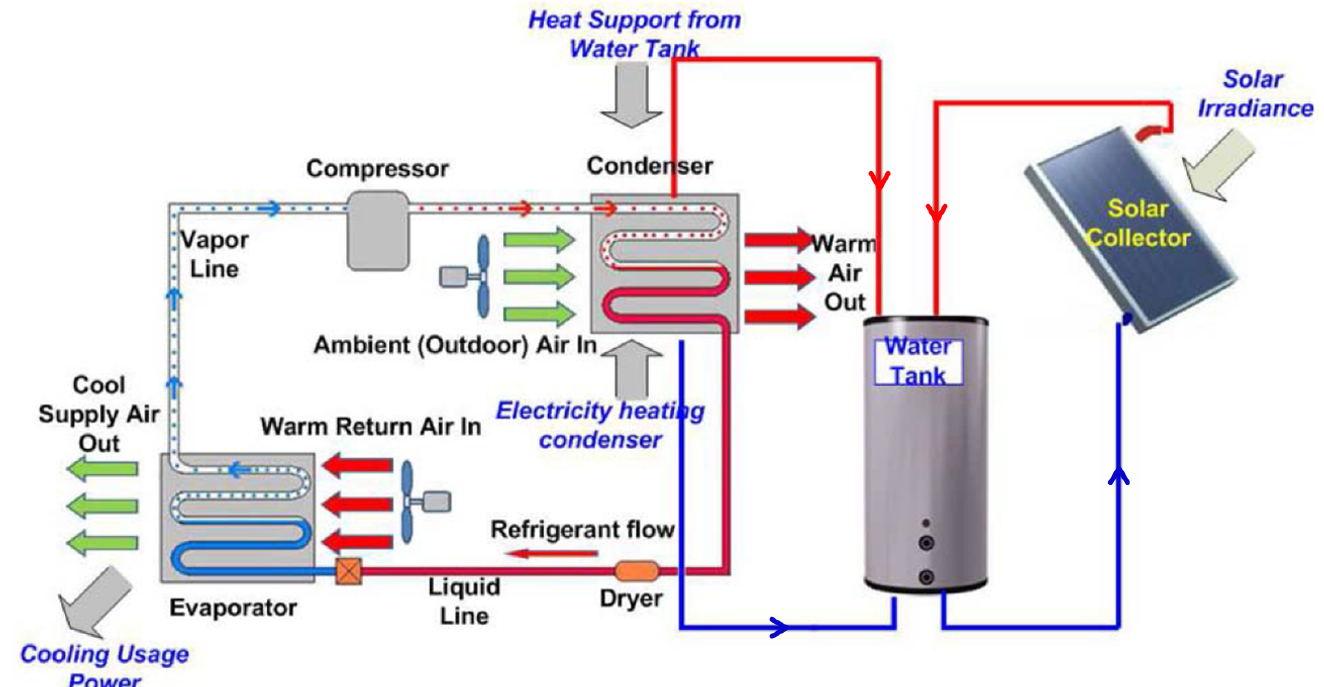
Figure 2. Solar-assisted HVAC system with flat-plate collector feeding a hot water tank storage connected to the HVAC system for heating application. (Adapted from [59] with permission of